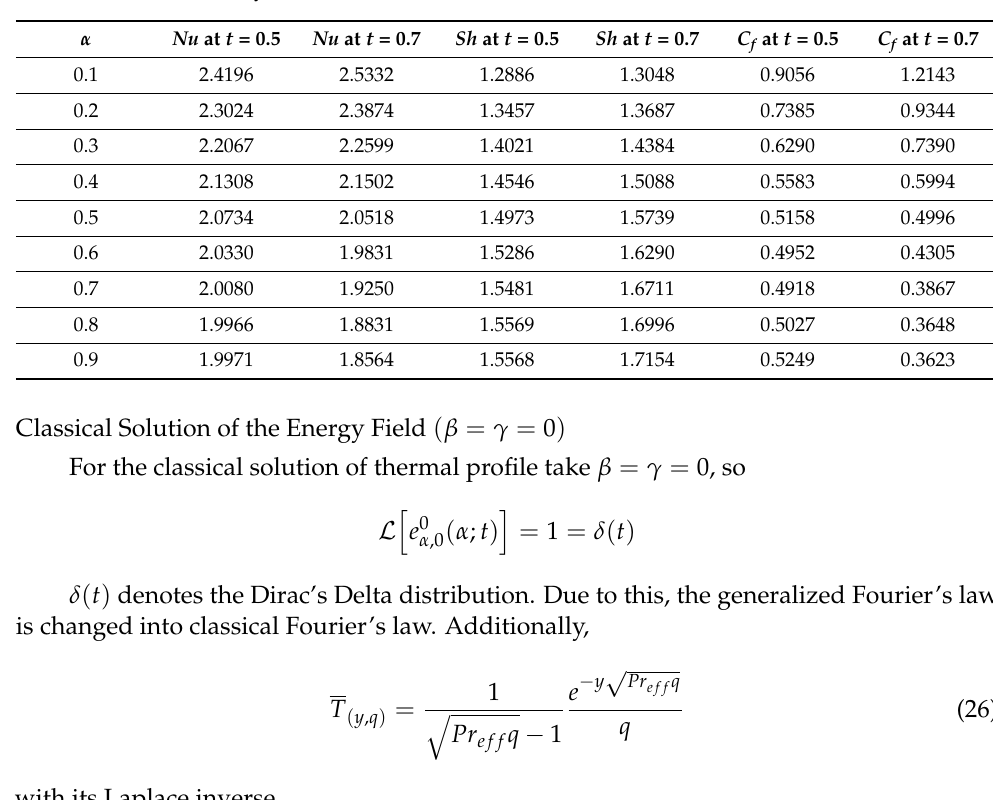
Table 2. Numerical analysis of Nusselt number, Sherwood number, and skin